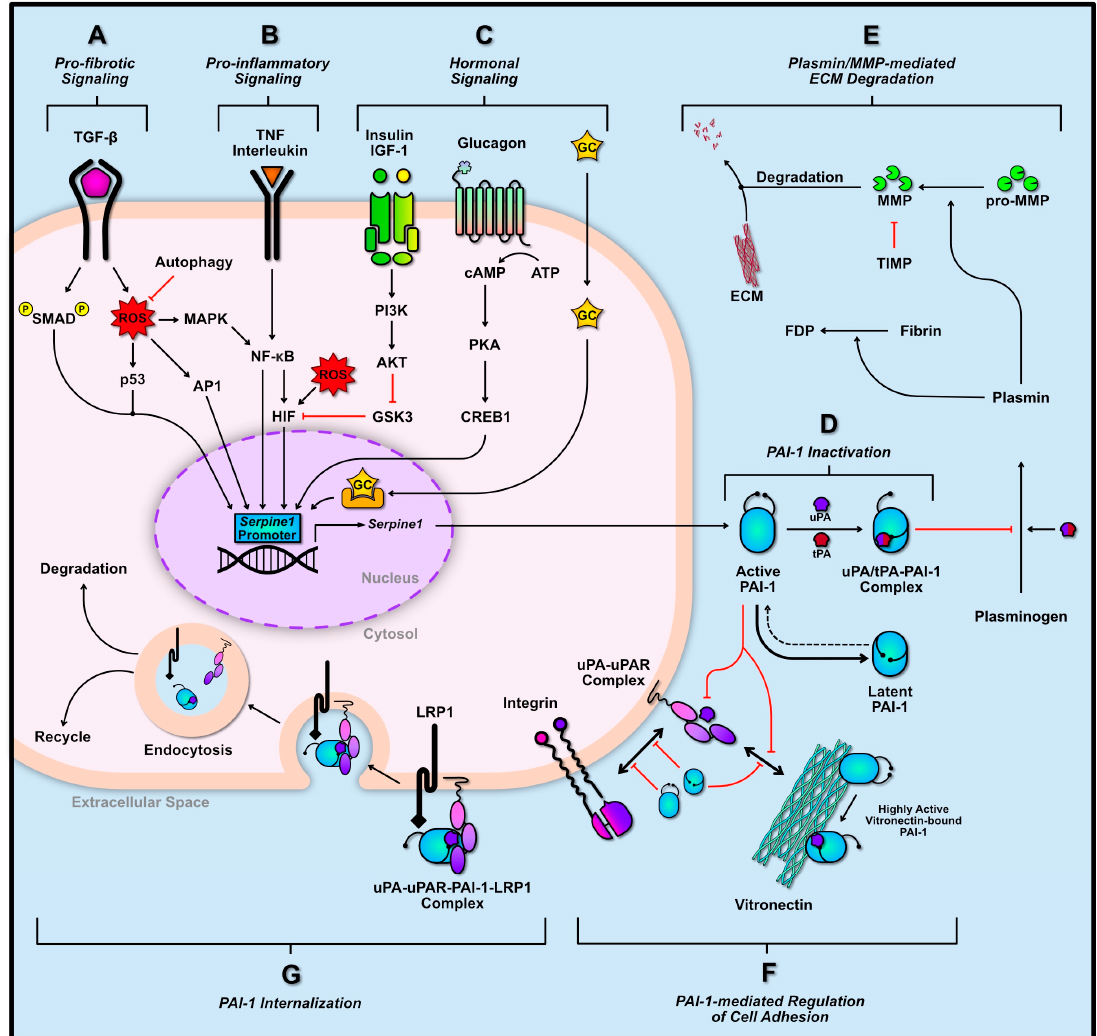
Figure 1. Serpine1 transcriptional regulation and PAI-1 function. Serpine1 can be transcribed through several signaling cascades including pro-fibrogenic ( A ), pro-inflammatory ( B ), and pro-growth / hormonal signaling cascades ( C ). Once transcribed, PAI-1 is secreted in its active form into the extracellular space where it can inhibit urokinase-type PA (uPA) / tissue-type PA (tPA), and thus inhibit downstream extracellular matrix (ECM) degradation by preventing matrix metalloproteinase (MMP) activation ( D , E ). Conversely, PAI-1 may be rapidly converted to its more stable latent state. The active and latent PAI-1 molecules can interact with uPA / uPA receptor (uPAR) and integrins to diminish cell adhesion to vitronectin ( F ). Vitronectin-bound PAI-1 prevents its premature conversion to its latent state and improves its binding a ffi nity to uPA / tPA. PAI-1 may also be internalized by the cell, through its interaction with lipoprotein receptor-related protein 1 (LRP1) and uPA / uPAR, ultimately leading to its degradation or recycling ( G ). Solid black arrows indicate activation. Dotted black lines indicate potential yet unfavorable pathways. Red bars indicate inhibition or blockage. Two-way arrows indicate interaction between proteins.